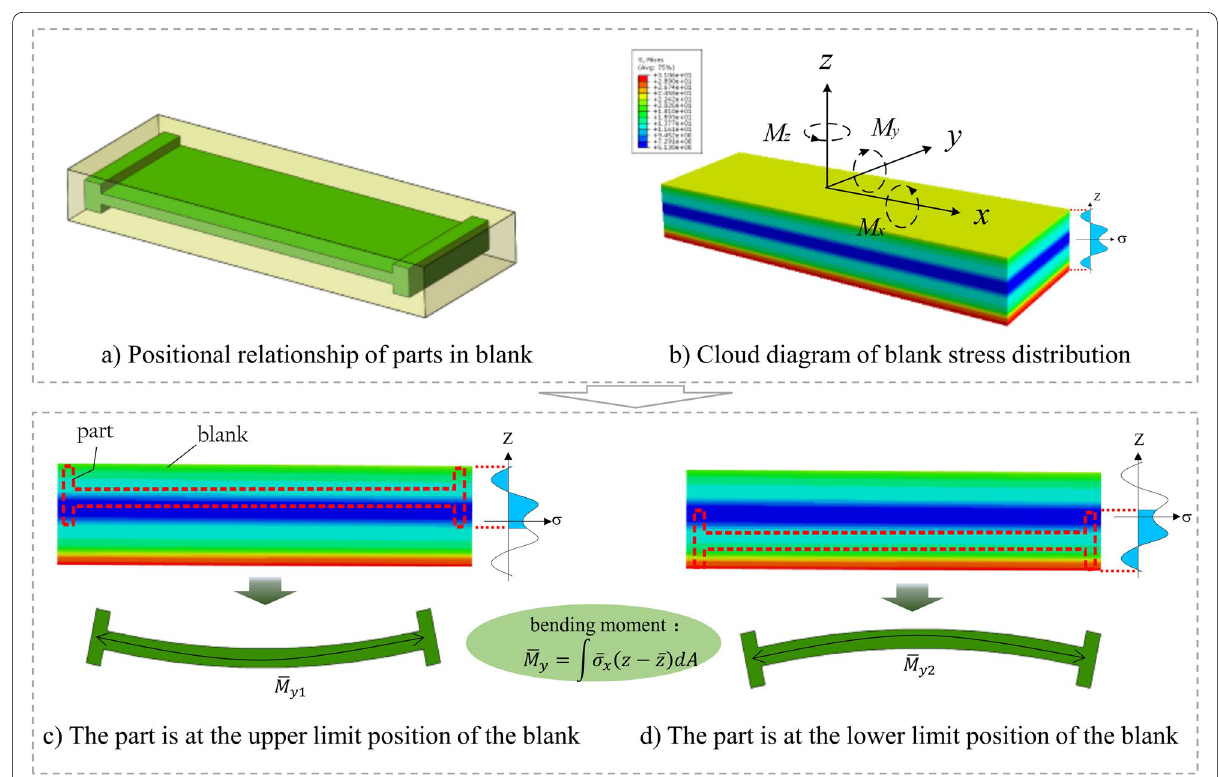
Fig. 1 Influence of machining position on deformation of machined